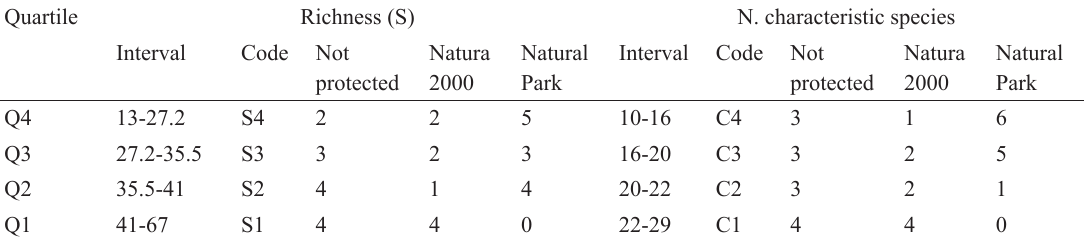
Table 4. Inventories classified in conservation indicator quartiles and their classification as a protection